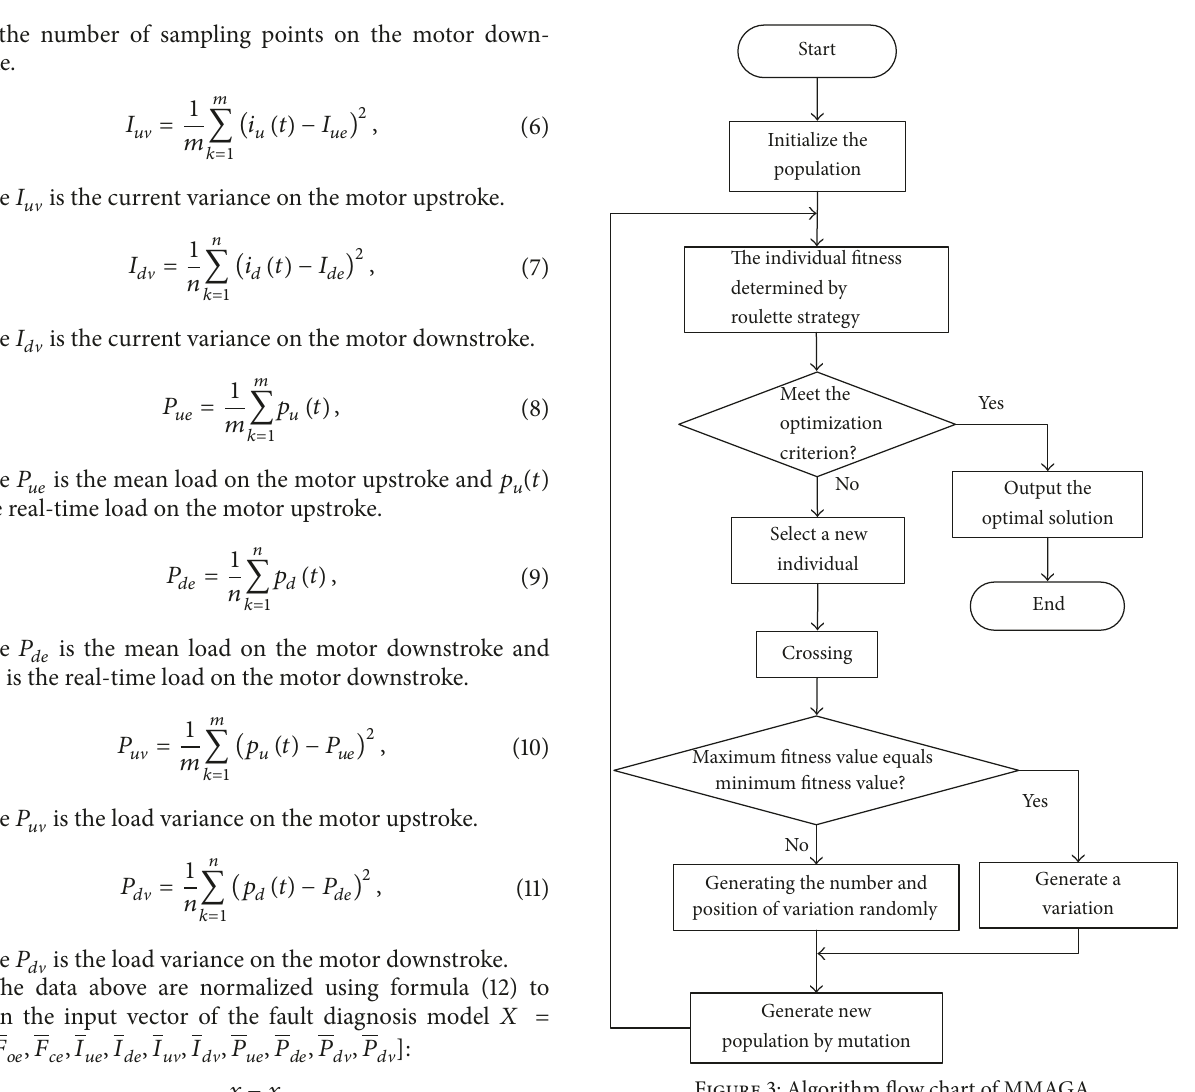
Figure 3: Algorithm flow chart of